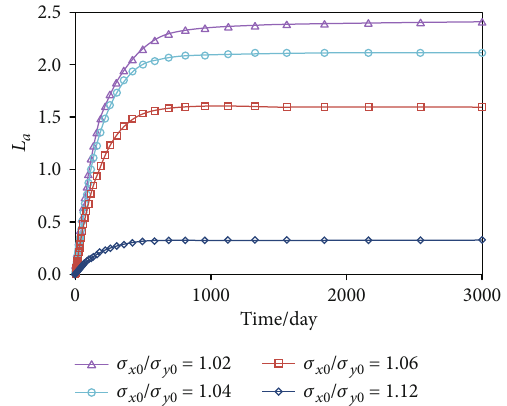
Figure 14: Initial horizontal stress ratio versus L